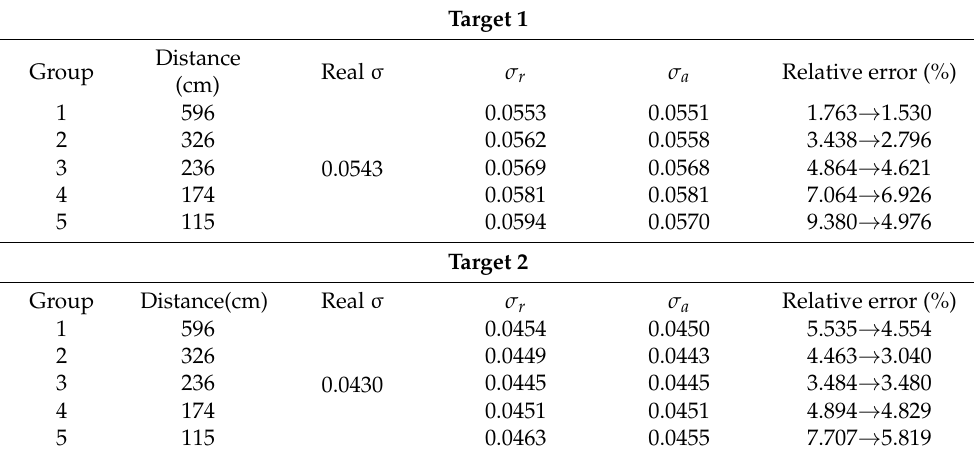
Table 2. Roughness inversion results of laboratory